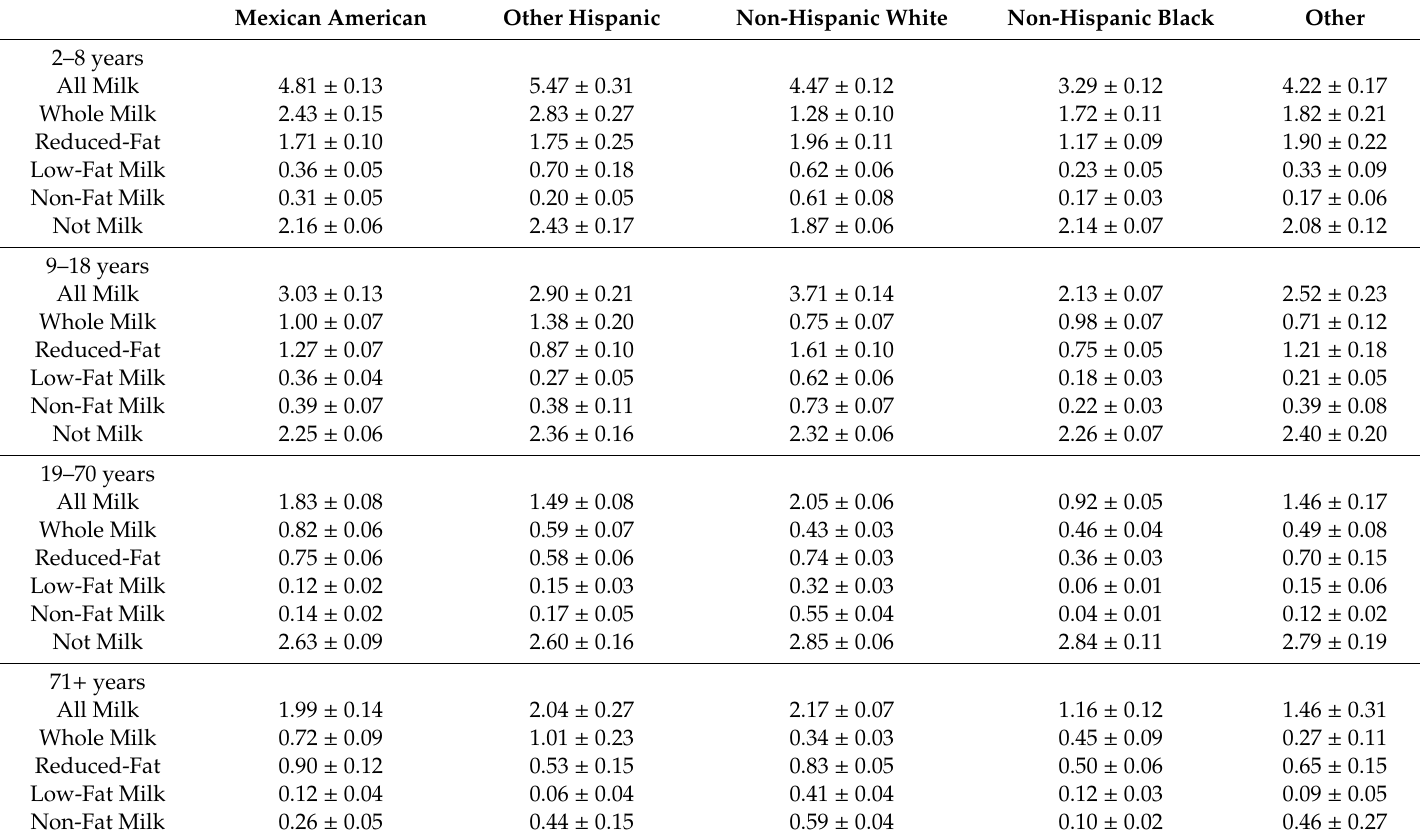
Table 3. Estimated mean dietary intake of vitamin D ( µ g / day) by milk type and by age and ethnicity. NHANES 2001–2010 Day 1 dietary